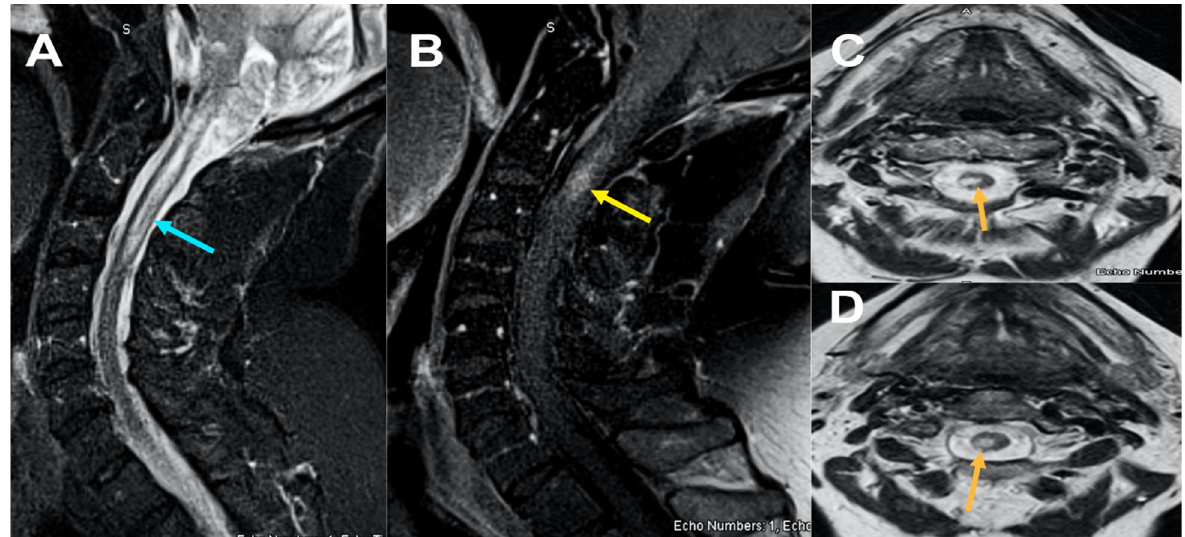
Figure 1. MRI Cervical spine Figure 1, sagittal STIR (short tau inversion recovery) images ( A ); sagittal T1 post contrast ( B ) and axial T2 weighted images at C2 and C3 level ( C ) and ( D ) reveals ill-defined long segment signal alteration with mild cord expansion extending from C1-C3 level (yellow arrow) ( A ) with corresponding hyperintensity on axial images ( C ) and ( D ) and abnormal enhancement on post contrast at C2 level ( B ) (yellow arrow).